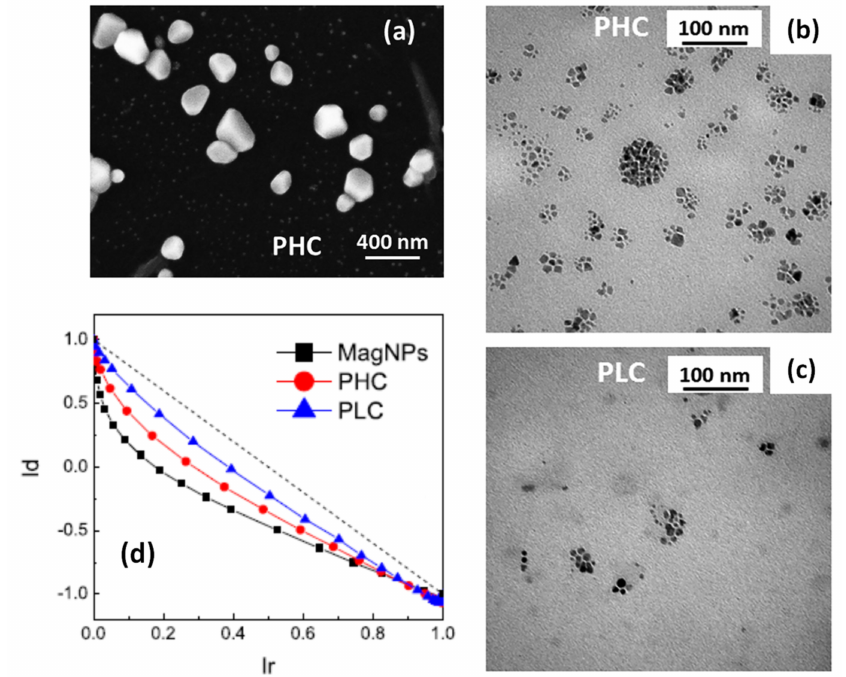
Figure 12. ( a ) SEM image of PLGA nanocapsules loaded with Mn-doped magnetite NPs. ( b , c ) Bright- field TEM images of the PLGA nanocapsules with higher (sample PHC) and lower (sample PLC) load of magnetic NPs, which provided the dark contrast. ( d ) Henkel plots for samples PHC, PLC and for the free magnetic NPs (sample MagNPs), obtained by combining the DCD and IRM magnetic remanence, measured by SQUID at T = 5 K. In particular, the normalized DCD values (Id) are plotted as a function of the normalized IRM values (Ir); the observed deviation from the linear trend (dotted line) is a measure of the strength of the dipolar interactions in the samples. Adapted with permission from Ref. [240], Copyright 2019 American Chemical